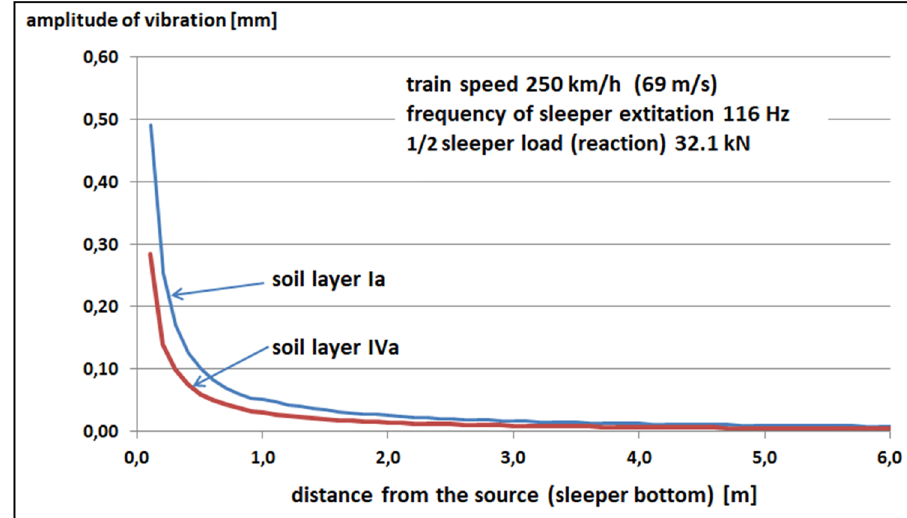
Table 8. Assuming small strain theory and taking the